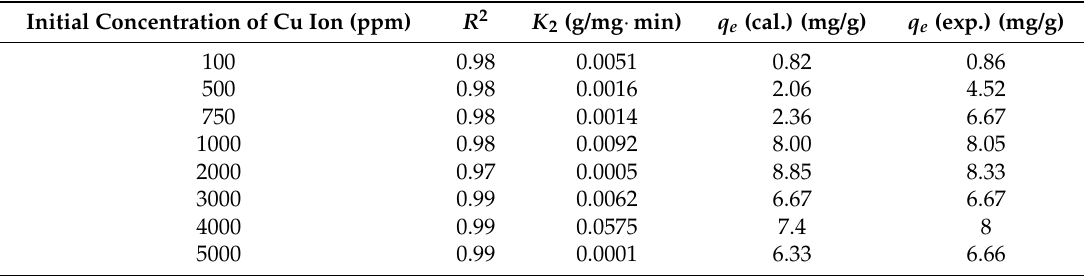
Estimated kinetic parameters of the second-order rate kinetic model at different copper